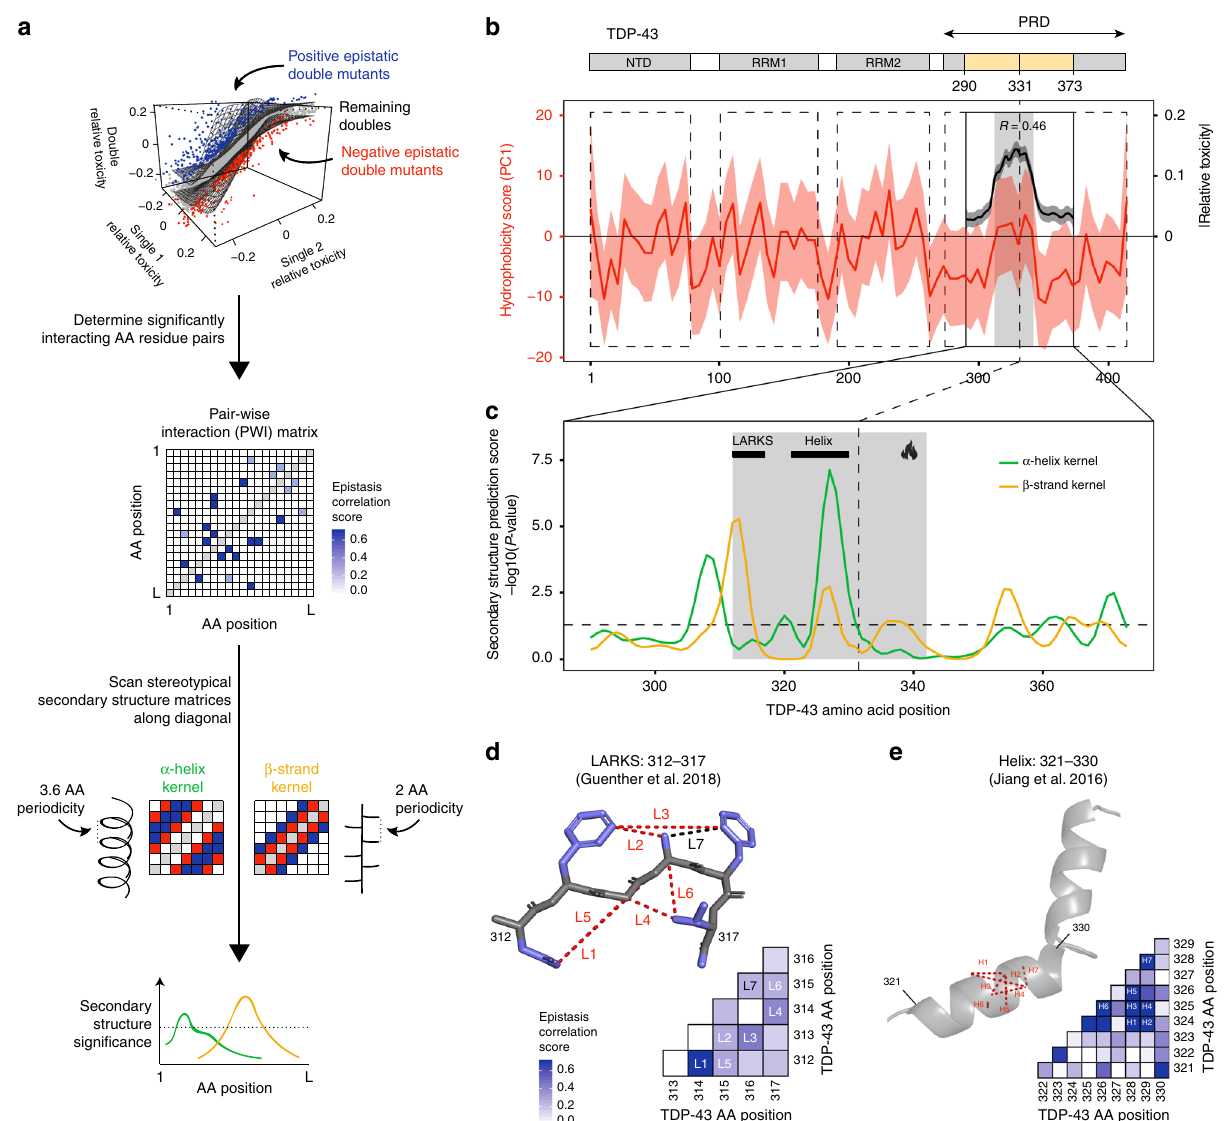
Fig. 4 Correlated patterns of epistasis predict secondary structural elements within the PRD of TDP-43. a Schematic representation of the computational strategy to identify in vivo secondary structures. Double mutant variants are classi fi ed as epistatic if they are more (95th percentile) or less (5th percentile) toxic than other variants with similar single mutant toxicities (top). A pair-wise interaction (PWI) matrix of epistasis correlation scores is then constructed by quantifying the similarity of a pair of positions ʼ interactions with all other mutated positions in the protein. The epistasis correlation scores along the diagonal of the PWI matrix are then tested for agreement with the stereotypical periodicity of α -helix and β -strand, using two-dimensional kernels (bottom), to calculate the likelihood of adjacent positions forming secondary structures. b Local polynomial regression (loess) of hydrophobicity (PC1) of the WT TDP-43 sequence with 95% con fi dence interval. For reference, smoothed toxicity estimates in the mutated positions within the PRD are shown. The Pearson correlation coef fi cient (R) between hydrophobicity and mean toxicity effects of single mutants at each position before smoothing is indicated. c Secondary structure predictions from epistasis correlation scores for α -helix and β -strand kernels based on the strategy described in panel a. Black bars annotate previously described structural features: LARKS, low-complexity aromatic-rich kinked segment (312 – 317) 52 ; Helix (321 – 330) 35 . The dashed horizontal line indicates the nominal signi fi cance threshold P = 0.05. d Epistatic interactions in region 312 – 317 are consistent with positions of similar side-chain orientations interacting in a previously reported in vitro LARKS structure. Epistasis correlation matrix and top seven epistasis correlation score interactions annotated on the LARKS reference structure (monomer from PDB entry 5whn, https://www.rcsb.org/structure/5WHN). Dashed lines on structure connect interacting residues at minimal distance between side chain heavy atoms. Side chain atoms are depicted in blue. e Epistatic interactions in region 321 – 330 are consistent with positions of similar side-chain orientations interacting in an α -helix. Epistasis correlation matrix and top seven epistasis correlation score interactions annotated on the Helix reference structure (monomer from PDB entry 5whn,